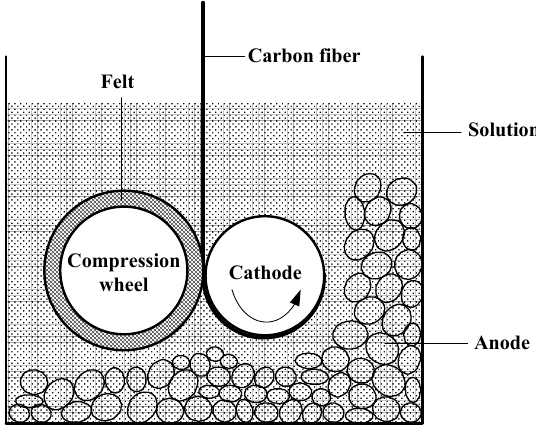
Figure 3: Schematic diagram of the flexible